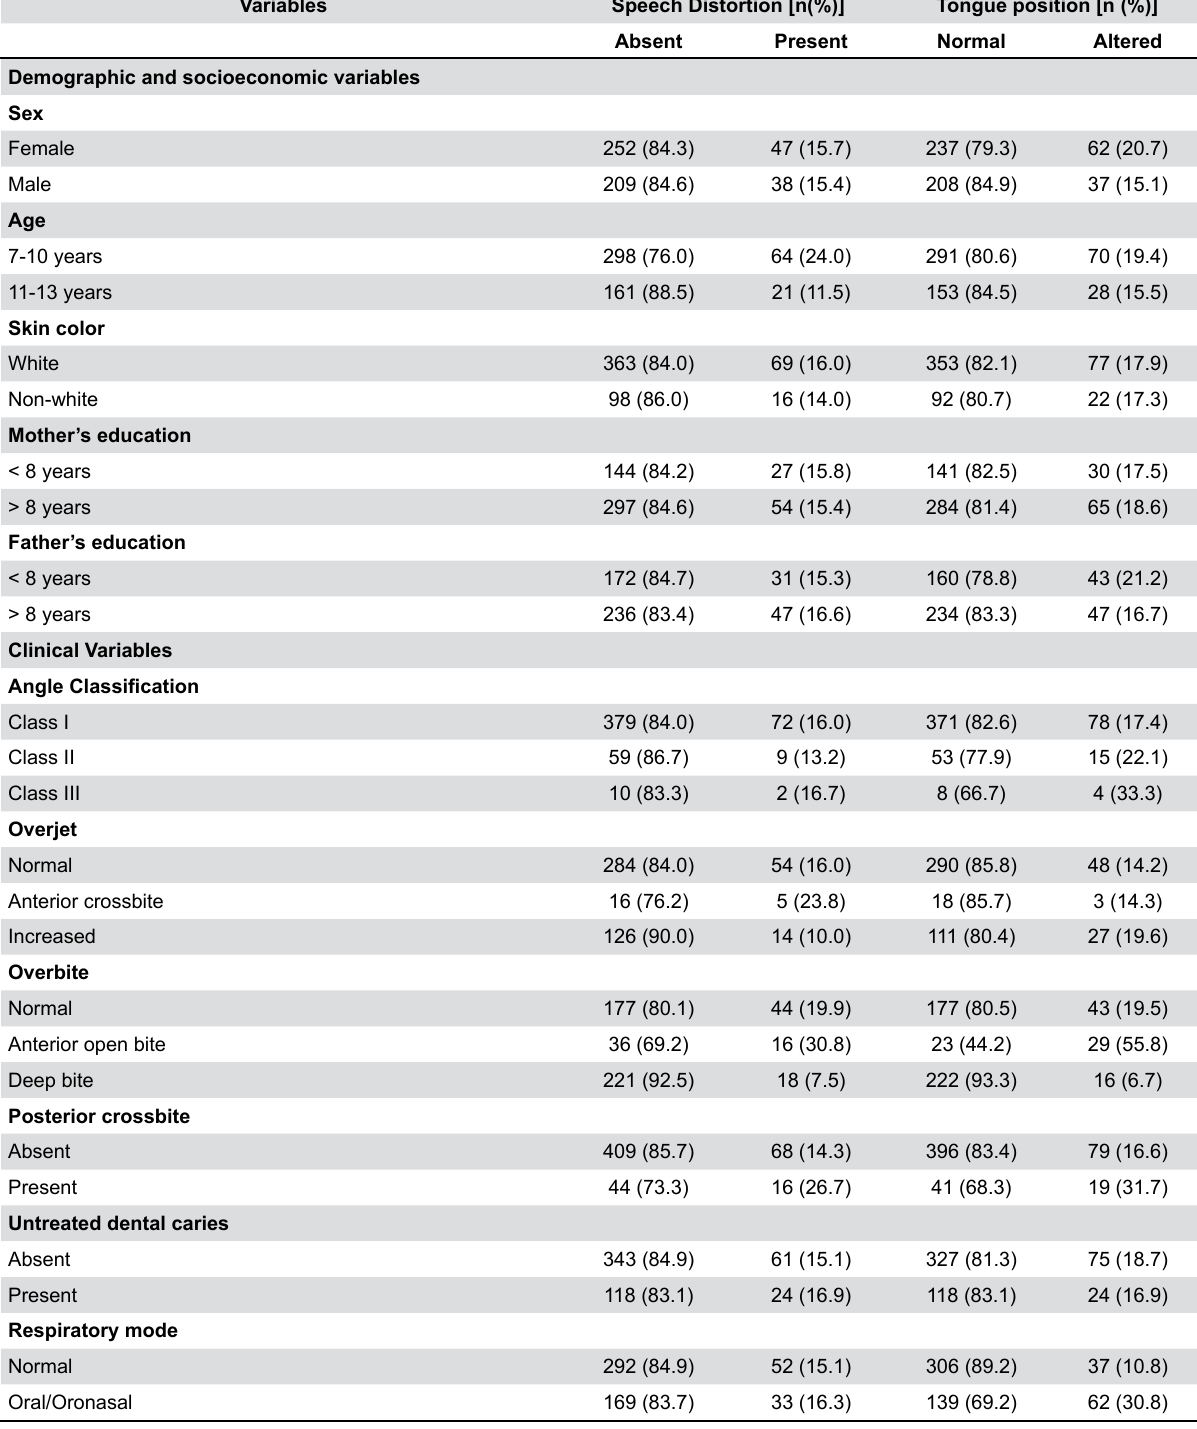
Table 2- Demographic, socioeconomic and clinical variables according to speech articulation disorders and tongue